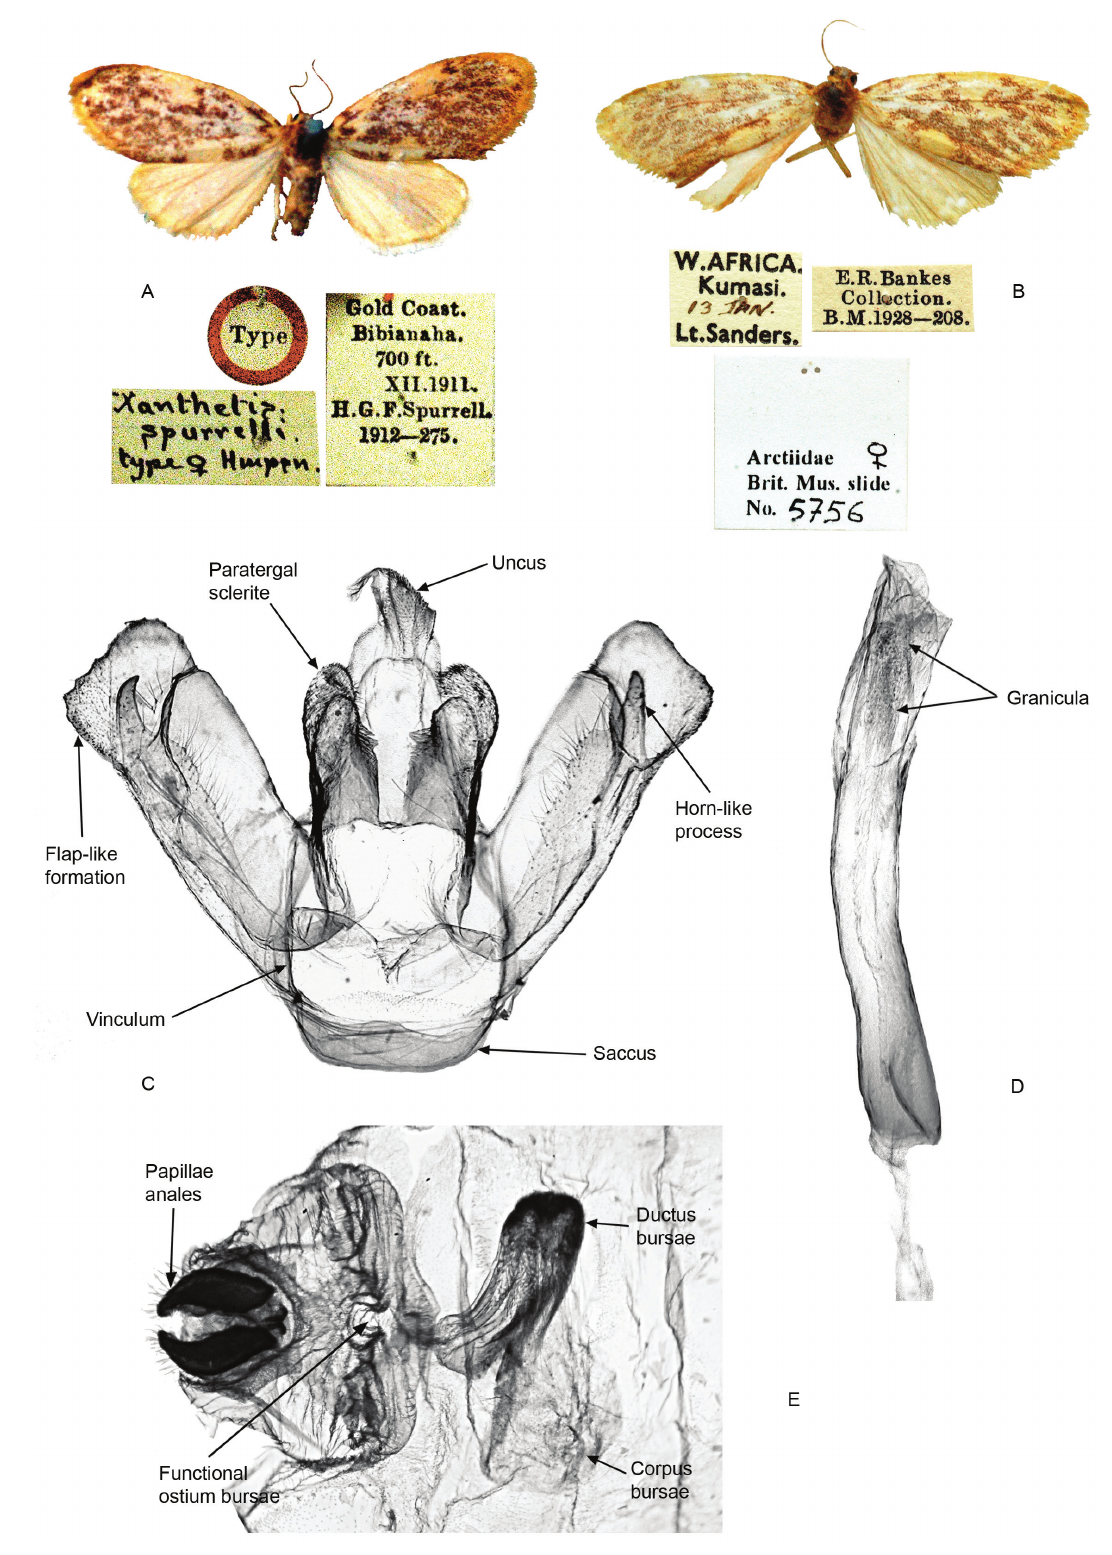
Fig. 3. Palaeugoa spurrelli (Hampson, 1914) . A . Syntype ♀, Ghana, in BMNH. B . ♀, Ghana, in BMNH. C . ♂ genitalia, g.sl. BM ARCT 301, Ghana. D . Aedeagus, g.sl. BM ARCT 301, Ghana. E . ♀ genitalia, g.sl. BM ARCT 5756,